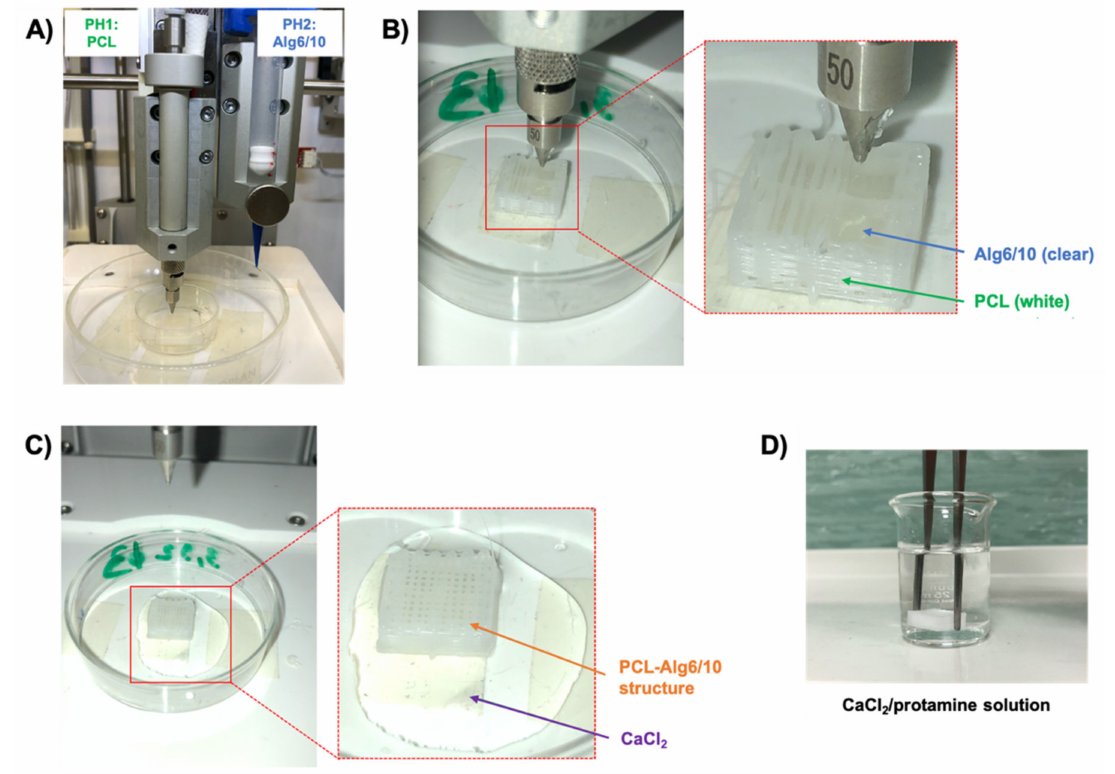
Figure 3. 3D coprinting setup and process of the parallelepiped-shaped scaffold. ( A ) PCL scaffold and lyosecretome-laden alginate (i.e., bioink) were 3D-printed using the PH1 and PH2, respectively. ( B ) The first part of the PCL scaffold was 3D-printed, forming the four little wells in which bioink was extruded. The last part of the structure was 3D-printed to cover the wells and create the “soft heart.” ( C ) The scaffold was first covered with a CaCl 2 solution for 5 min. ( D ) Finally, the scaffold was immersed into a CaCl 2 solution, and it was gently shaken for 5 min to allow the solution to go beyond the PCL scaffold and reach the bioink. For double cross-linking, the scaffold was later immersed into a protamine solution and stirred gently for a further 5